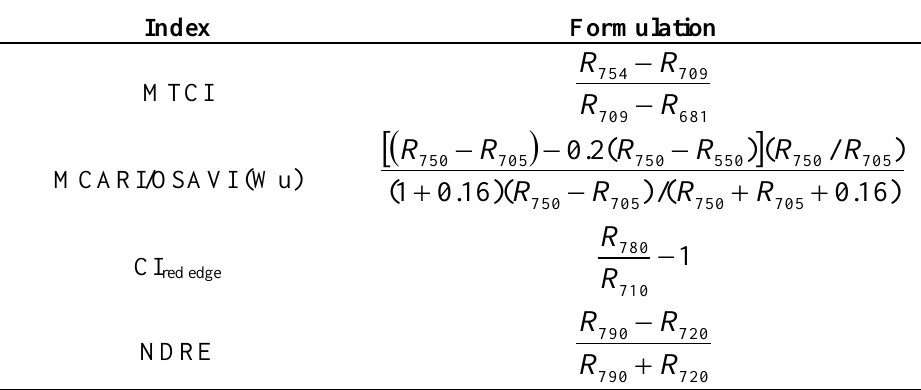
Table 1. Equations and wavelengths of the selected vegetation